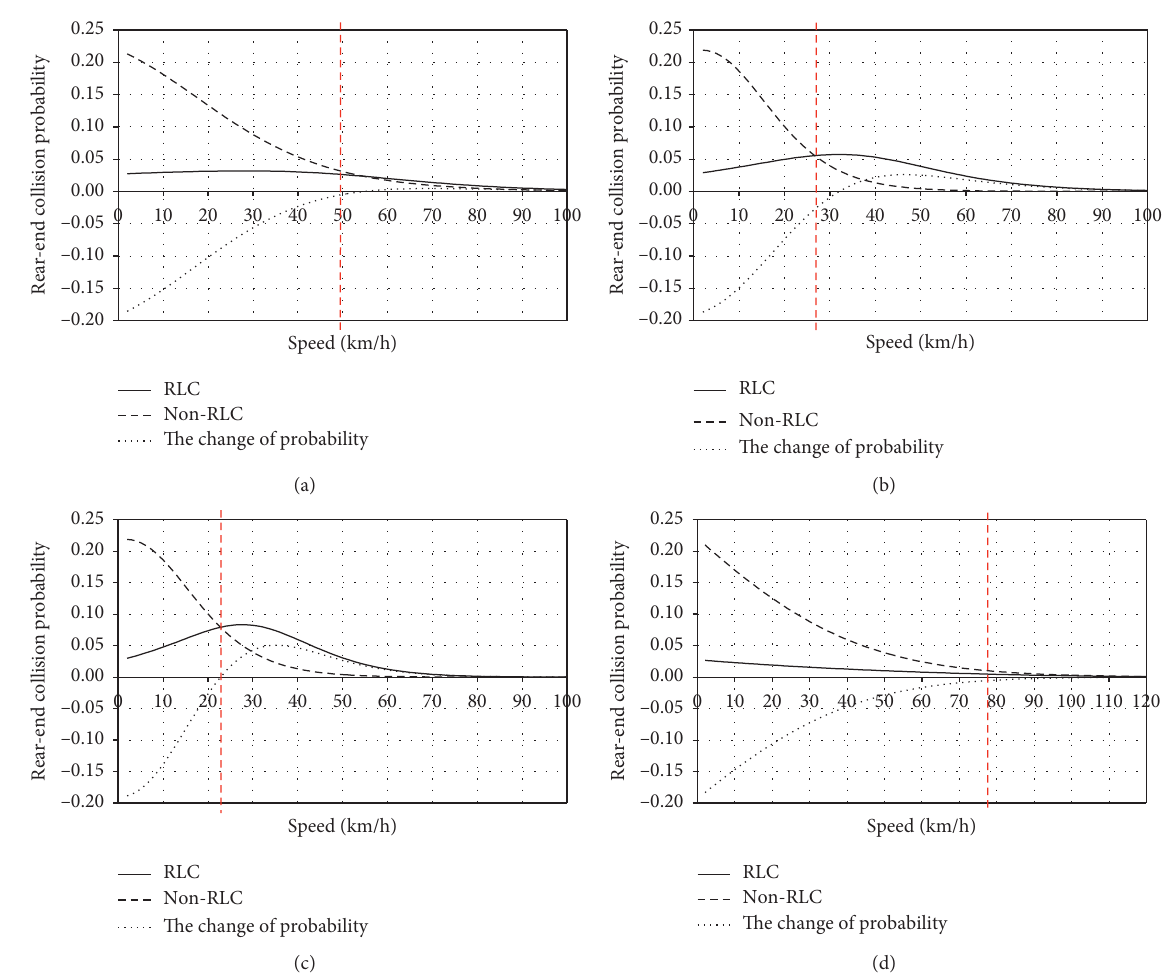
Figure 7: Probability of rear-end collisions with different potential travel time. Through the analysis of the above probability curve, the following can be found: (a) Potential travel time � 1.0s. (b) Potential travel time � 2.0s. (c) Potential travel time � 3.0s. (d) Potential travel time � 4.0s.